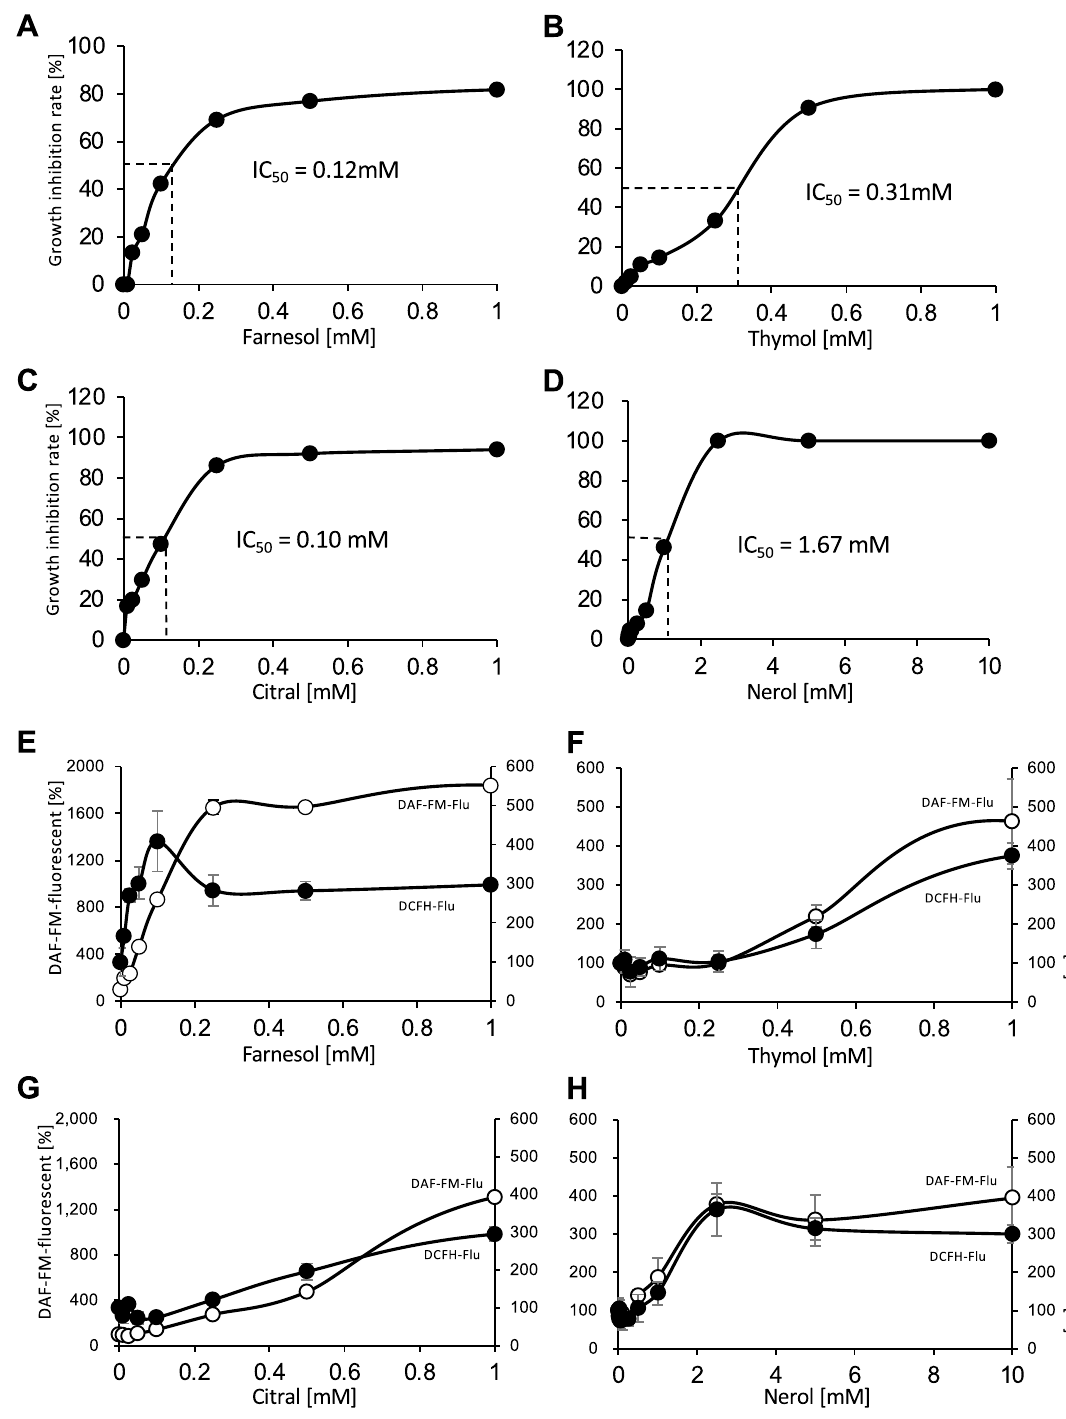
Figure 3. Relationships between antifungal compound concentrations and the growth inhibitory effects or productions of DCFH- and DAF-FM-related fluorescence. The growth inhibition rates were determined after treatment with different concentrations of farnesol, thymol, citral, and nerol ( A – D , respectively). The calculated IC 50 values are depicted in the graph. The induced DCFH- and DAF-FM-related fluorescence intensity levels, shown by black and white circles, respectively, were measured after treatment with farnesol, thymol, citral, and nerol ( E – H ,